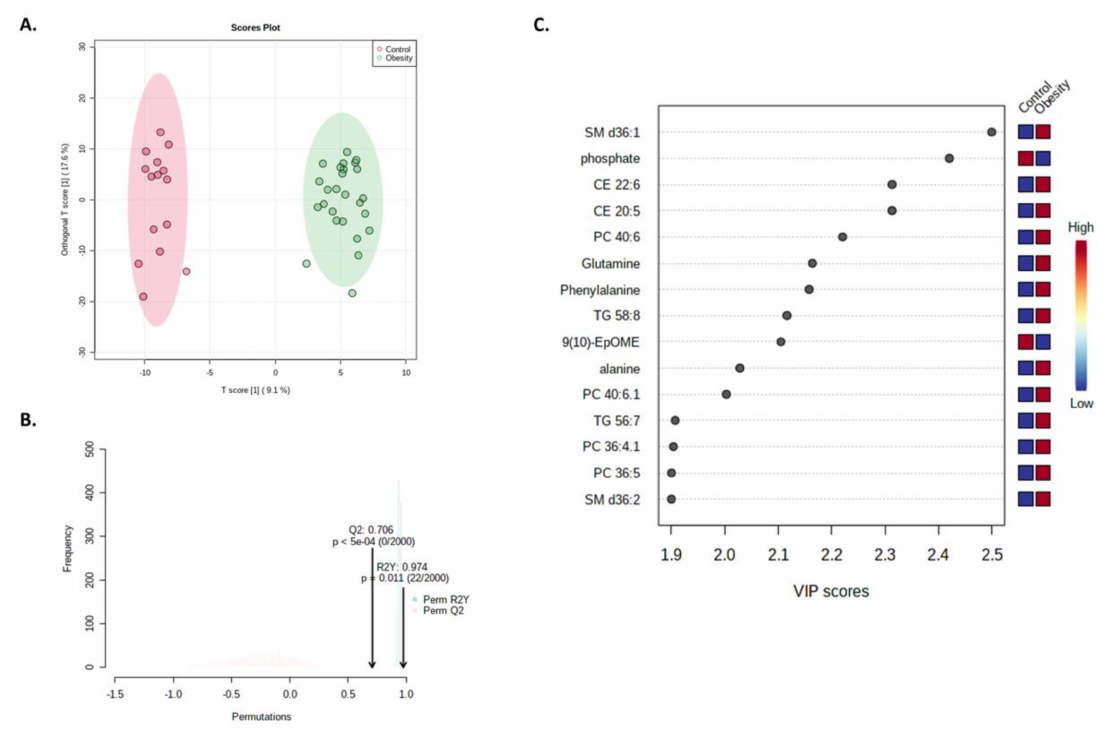
Figure 7. OPLS-DA analysis between patient groups. ( A ) Score plot of all metabolite features. ( B ) Permutation analysis with observed and cross-validated R2Y and Q2 coefficients. ( C ) Important metabolites identified by OPLS-DA. Colored boxes on the right indicate metabolite concentrations in each patient group. SM, sphingomyelin; PC, phosphatidylcholine; CE, cholesteryl ester; TG, triacylglycerol; 9,10-EpOME, 9,10-epoxyoctadecenoic